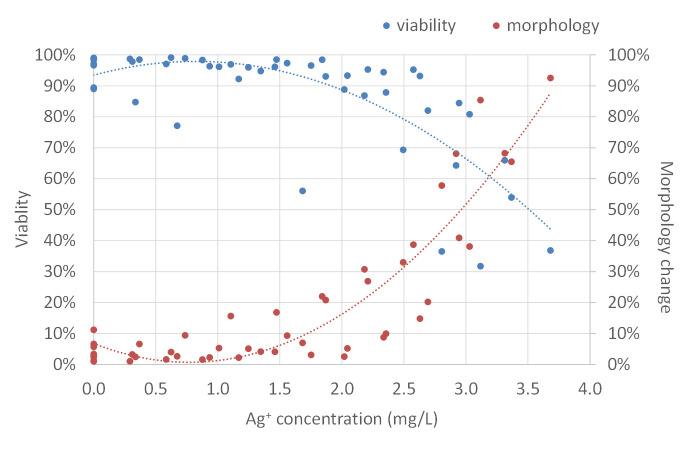
Correlation of fibroblast cell viability and morphology change in response to different concentrations of electrically generated silver ions.Cell viability (blue dots) was analyzed by trypan blue staining. Morphology change (red dots) was assessed by the “Image Analysis” module of Axiovision software. Polynomial trendlines of cell viability and morphology change are shown in blue dot line and red dot line, respectively. Silver ion concentration (mg/L) was determined by ICP-MS. Experiments were repeated four times.